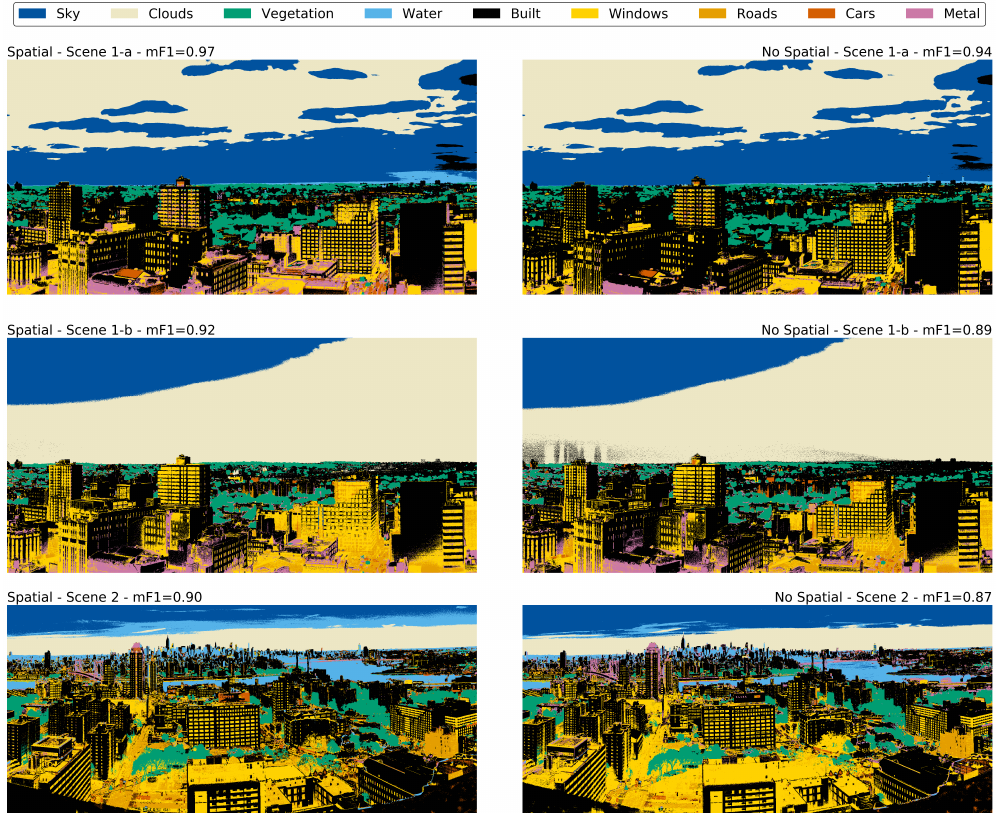
Figure 7. Image segmentation results from CNN Model 2 for each of the three scenes in Figure 1, both with ( left ) and without ( right ) spatial information included and used to classify pixels in each scene. Model 2 with spatial information included marginally outperformed the variant without when segmenting each scene. The per class results are quantified in Table